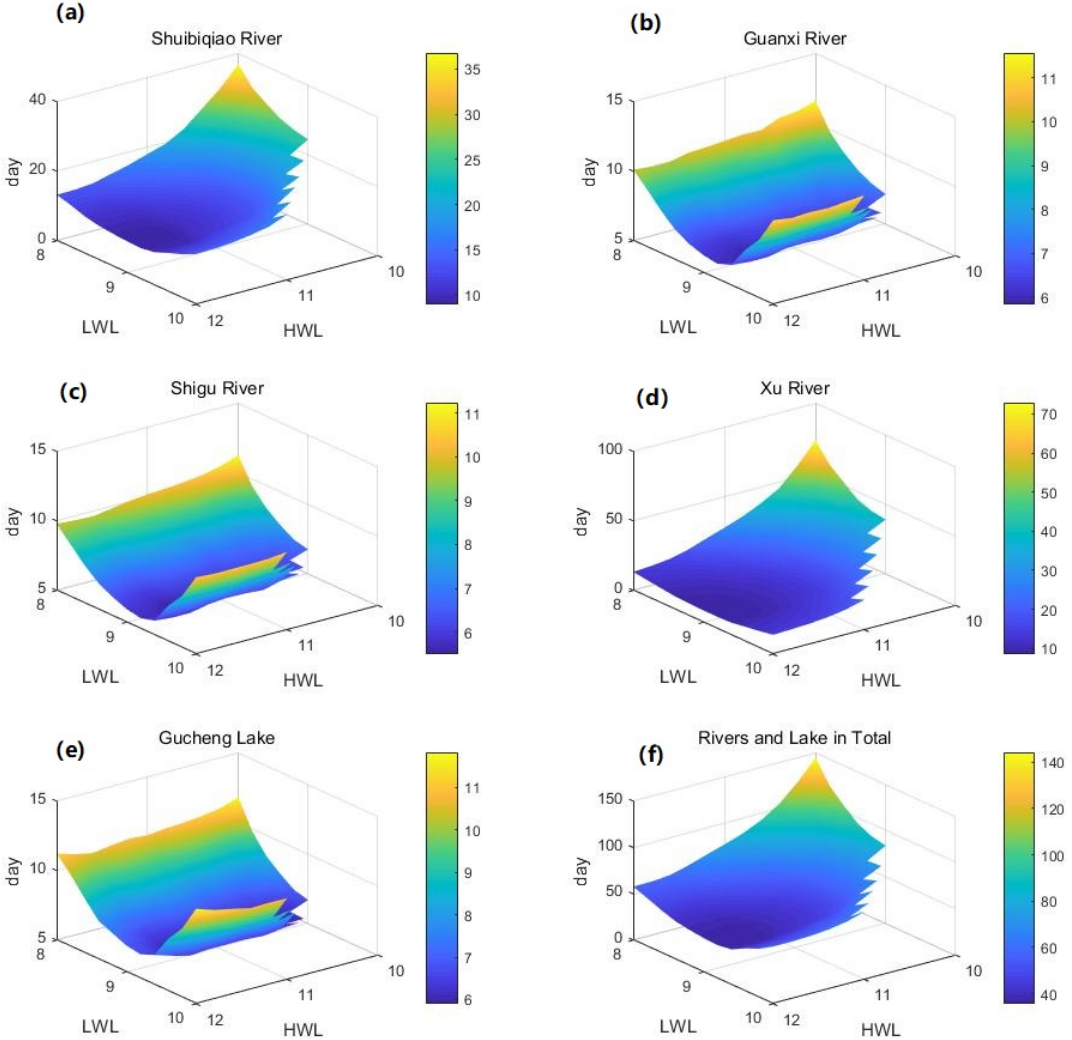
Figure 3. The mean annual days when the water level is higher than the maximum water level of the ( a ) Shuibiqiao River, ( b ) Guanxi River, ( c ) Shigu River, ( d ) Xu River, ( e ) Gucheng Lake and ( f ) Rivers and Lake in Total, under different regulation scenarios combined by LWL and HWL. Table 5. The statistical days when the water level is higher than maximum water level under different regulation scenarios.